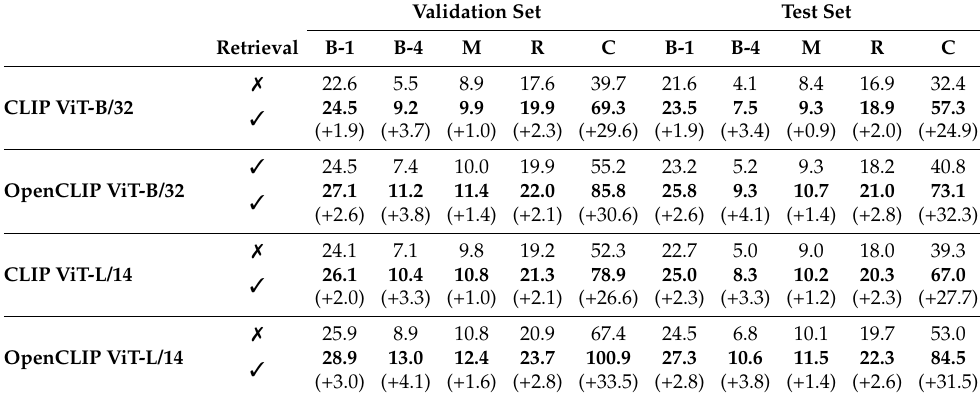
Table 2. Ablation study results on the FACAD validation and test splits using different visual